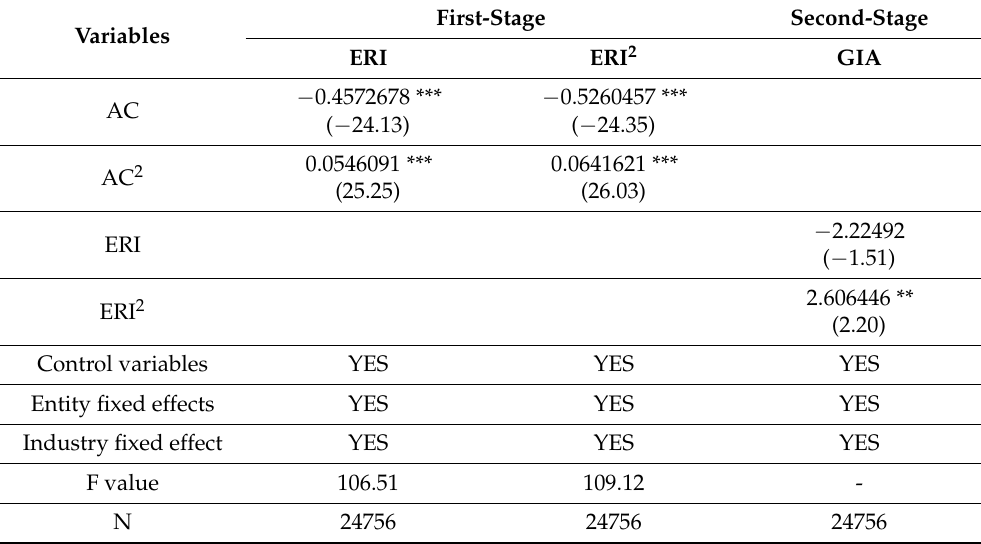
Table 8. Endogenous test: instrumental variables.